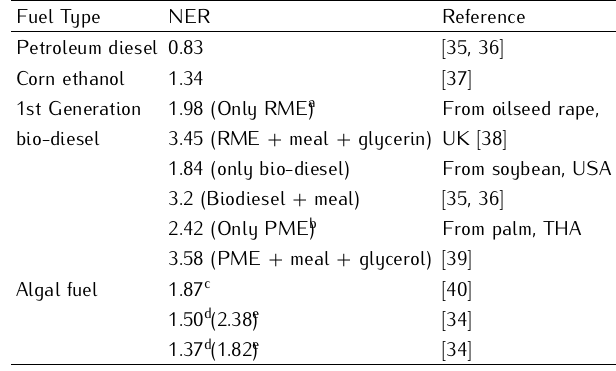
Table 2. Net energy ratios for different renewable fuel sources